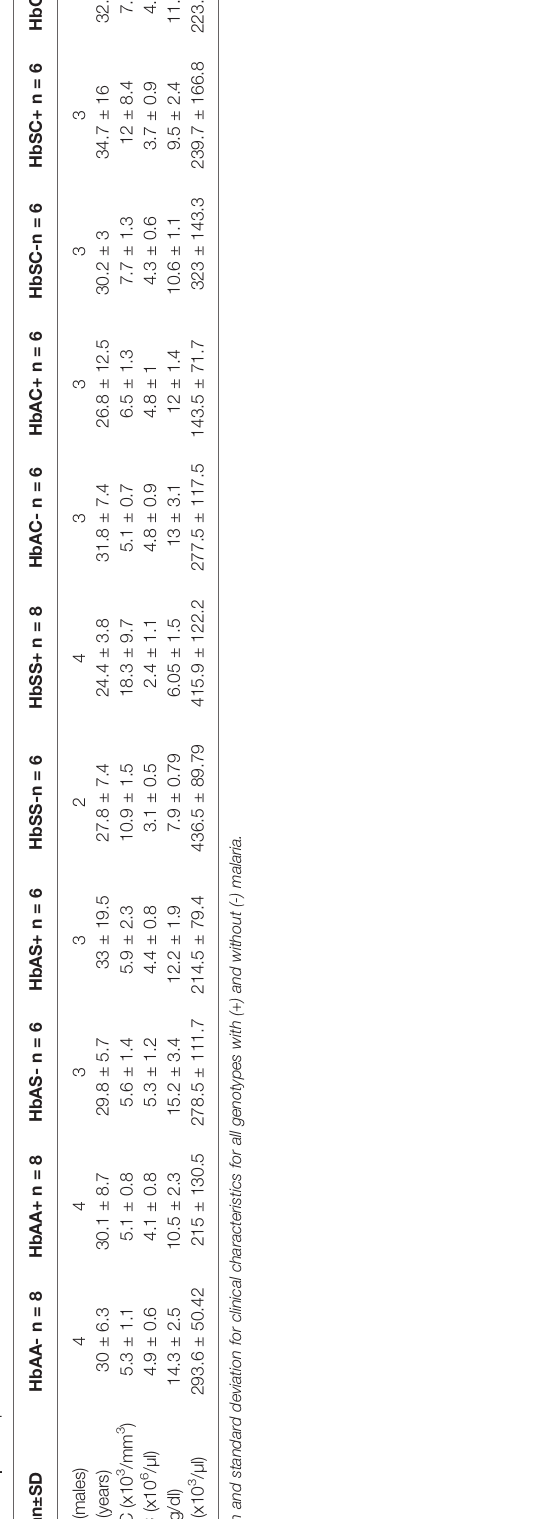
ROC curves and corresponding area under curve